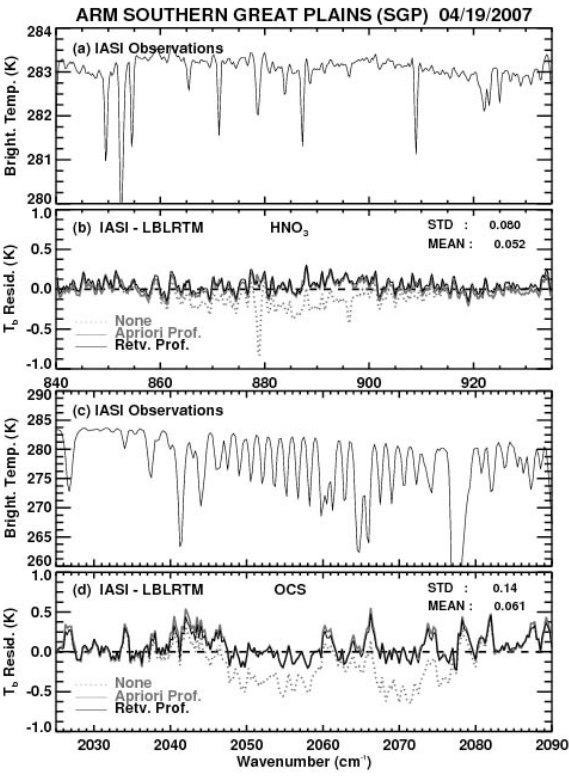
Fig. 22. Brightness temperature observations and residuals (IASI- LBLRTM) for the ARM SGP case for the HNO 3 (a, b) and the OCS (c, d) spectral